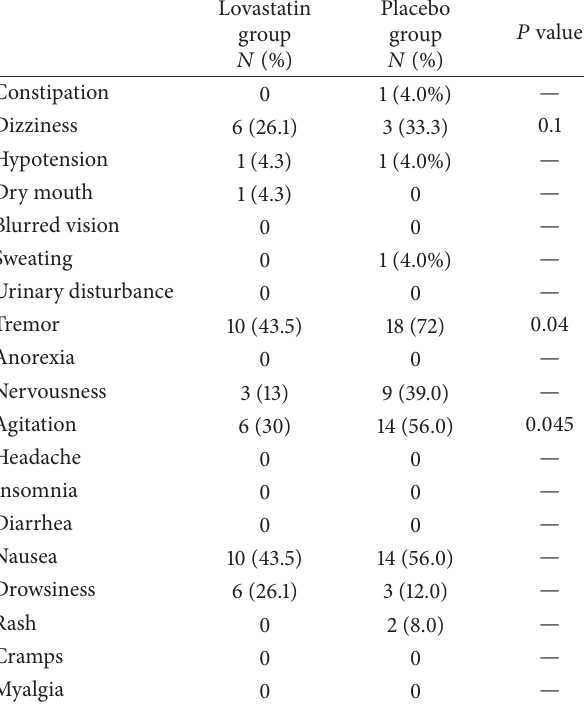
Table 3: The rate of adverse effects in both